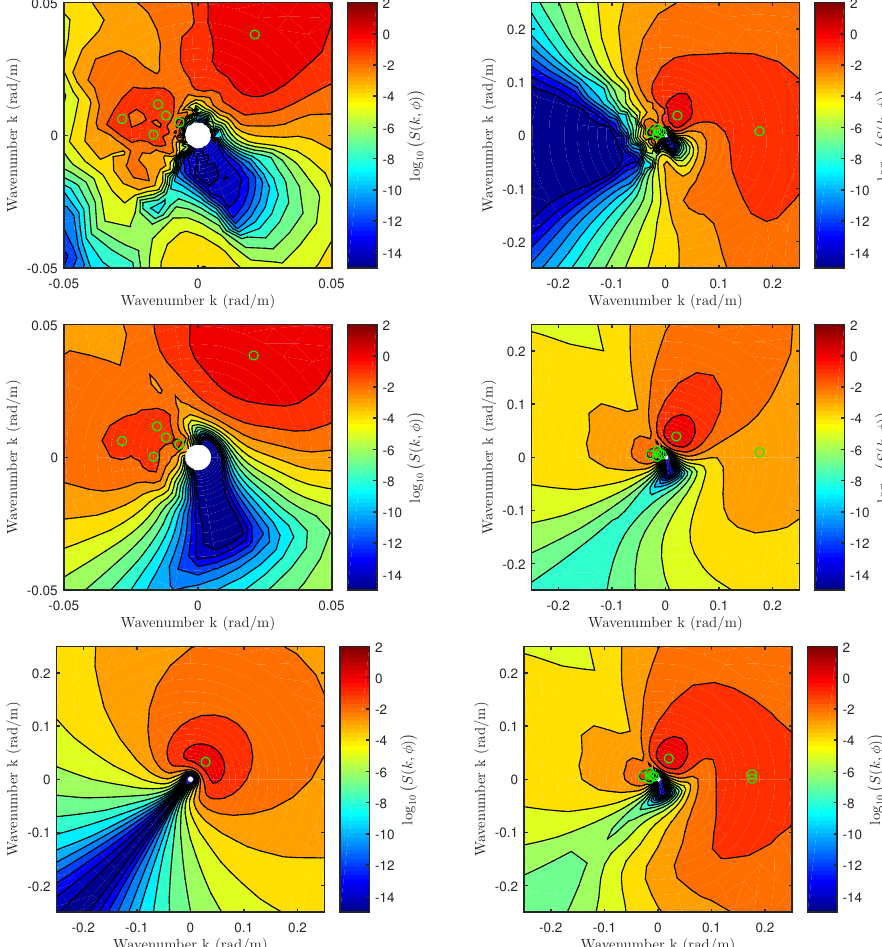
Figure 11. A comparison of NDBC buoy spectra and approximated 2D spectra. Plots shown are as follows: ( top row ): NDBC buoy 46002 spectrum on 2 May 2015 at 00:00:00 UTC ( u 10 = 5.63 m/s and φ = 50.3 ◦ ); ( left ) zoomed-in view; ( right ) zoomed-out view. ( Middle row ): approximated swell-only buoy spectrum using non-zero WW3 partitions; ( left ) zoomed-in view; ( right ) zoomed-out view. ( Bottom row ): ( left ) swell-only spectrum approximated using WW3 0th-partition data; ( right ) middle-right plot with wind contributions added. All plots are in the up-cross-wind coordinate system. See text for more